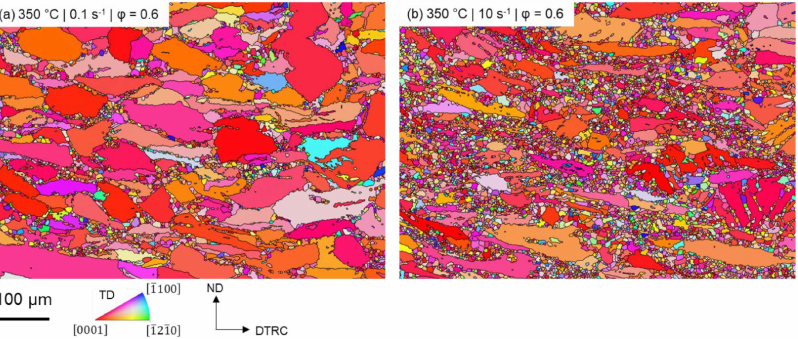
Figure 2. Inverse pole figure (IPF) maps of the ZAX210 alloy after plane strain compression at 350 ◦ C under a strain rate of ( a ) 0.1 s − 1 and ( b ) 10 s − 1 and an equivalent logarithmic strain of